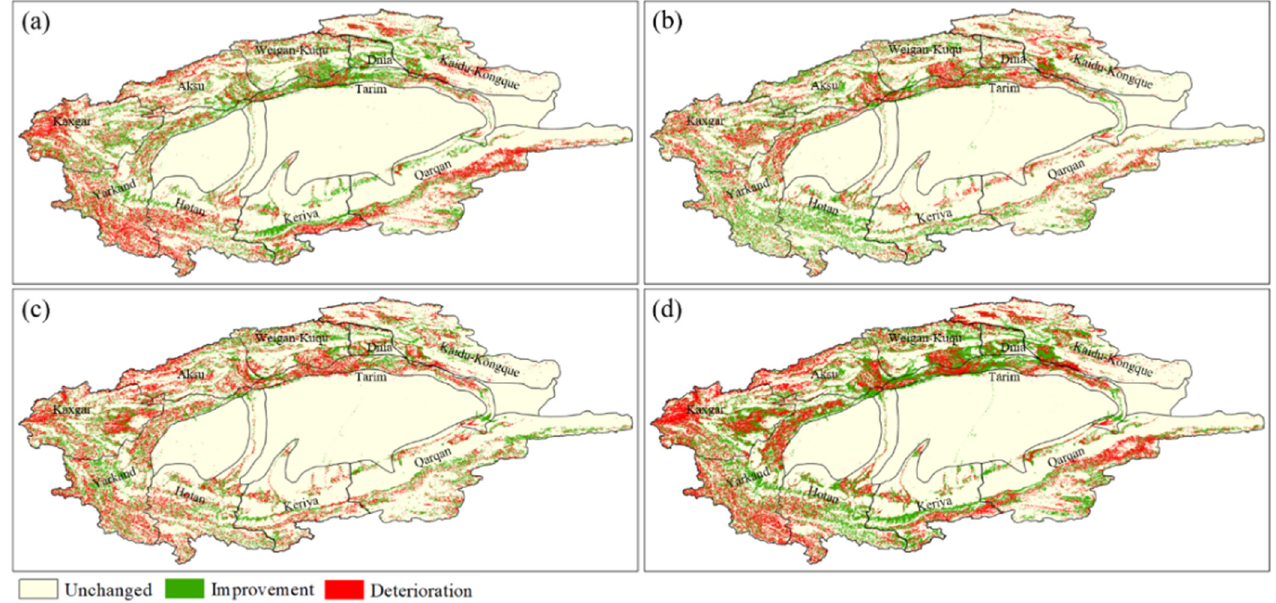
Figure 6. Changes in ecological environment in the Tarim River Basin from 1990 to 2019: ( a ) 1990–2000; ( b ) 2000–2010; ( c ) 2010–2019; and ( d ) 1990–2019.